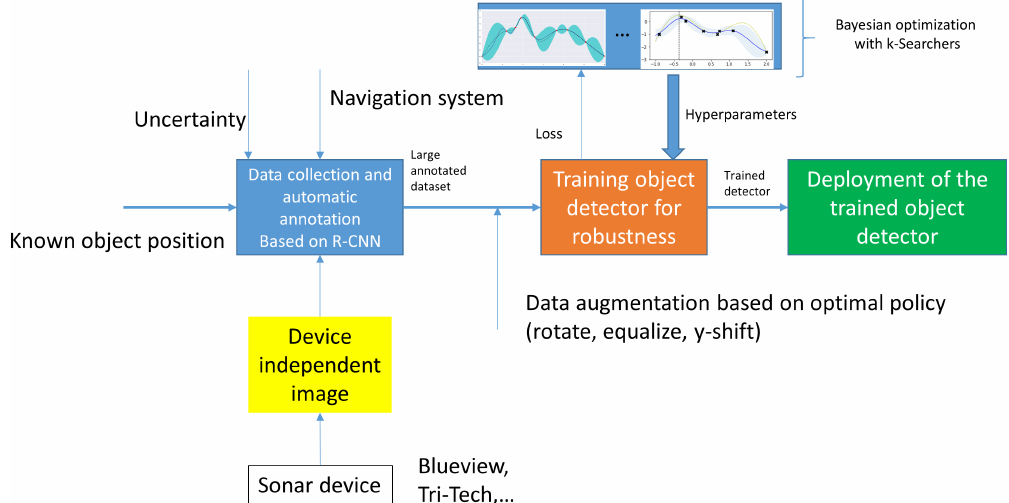
Figure 2. Workflow of realizing the object detector, starting from manual data collection, training a simple Region-based Convolutional Neural Network (R-CNN) and collecting large dataset, training the final detector and